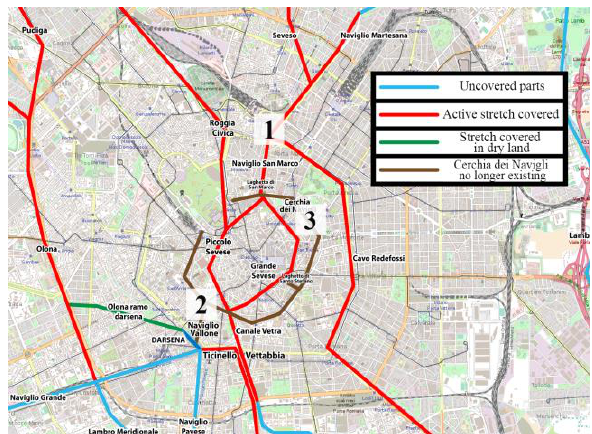
Figure 2 . The Cerchia dei Navigli: Map of the city of Milan Figure 3 . The research case studies located on the google map published by the municipal administration, highlighting the of Milan, Italy: (1) Conca dell’Incoronata, (2) Conca di waterways. Viarenna and (3) Via Senato.